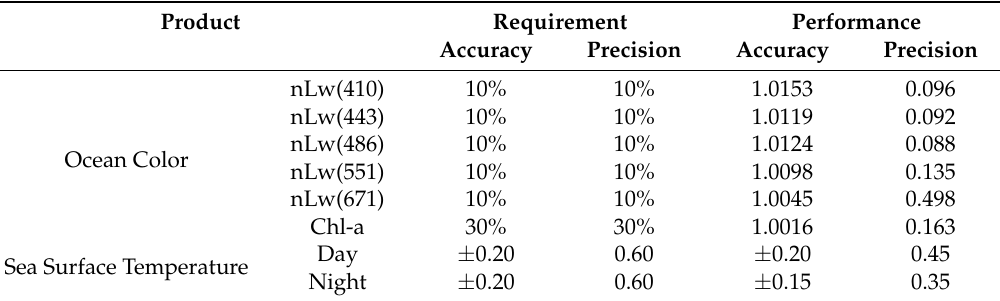
Figure 6. S-NPP ocean color climatology Chl-a (2012–2016). In addition to (MSL12) OC processing system NRT products (meeting latency requirements), the OC team also produces JPSS-VIIRS reprocessed ocean-color products for the best quality mission-long S-NPP OC data products to benefit users worldwide. (Figure courtesy: Menghua Wang, STAR OC team). Table 6. S-NPP VIIRS ocean products